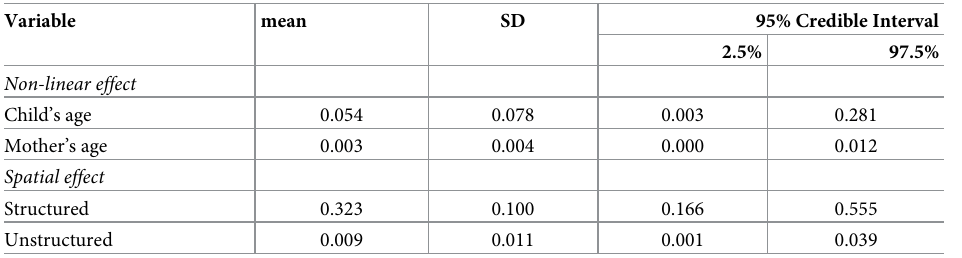
Table 7. Posterior estimates of smooth term variance